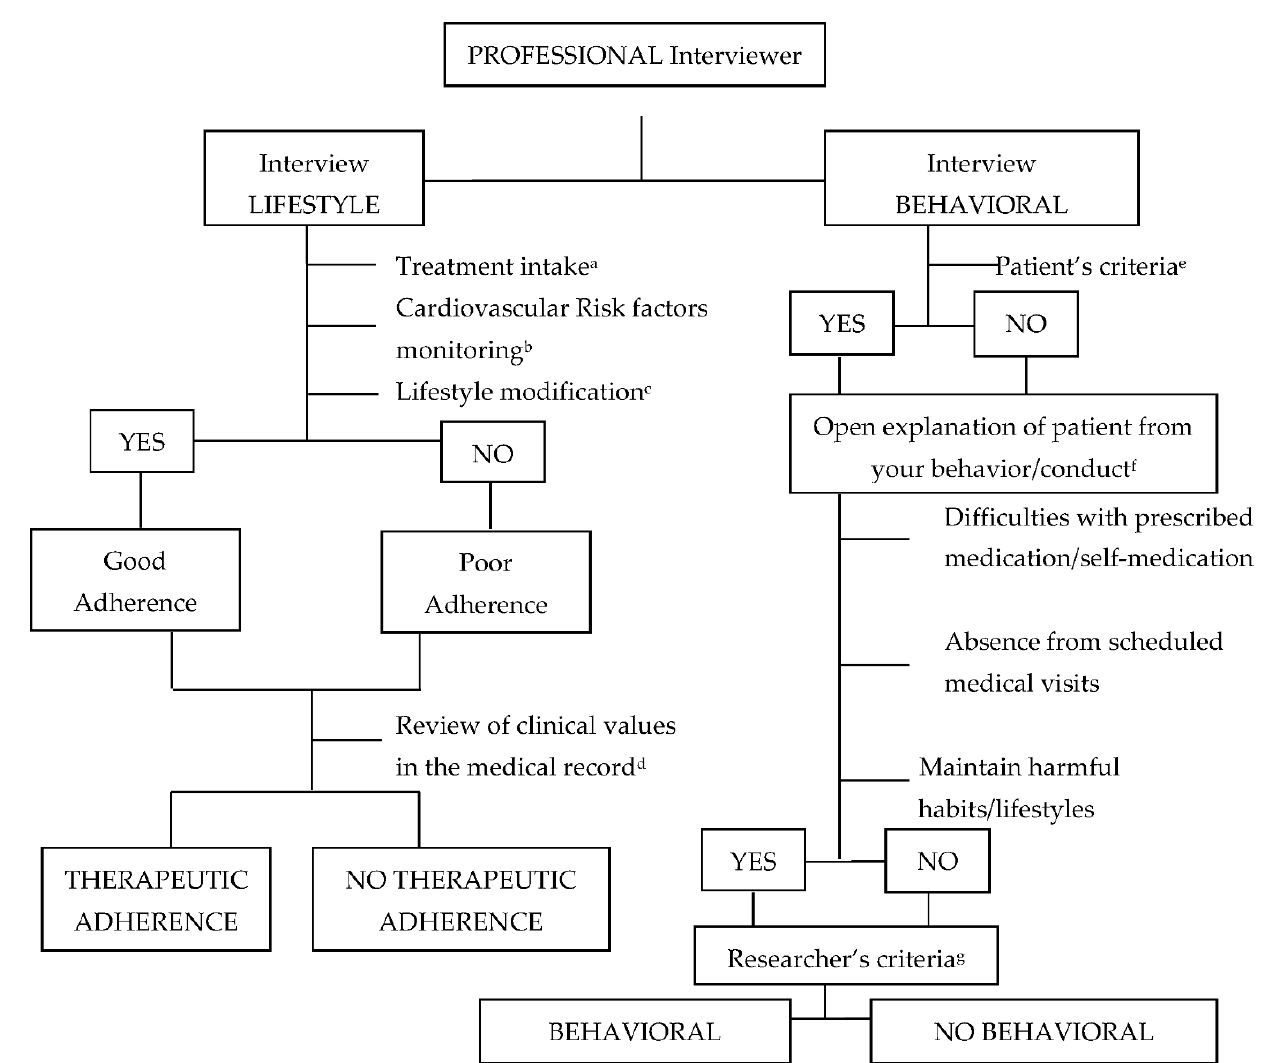
Figure 2. Algorithm to classify lifestyle and behavioral changes. a Patient self-report on taking prescribed medication without missing any doses [19]. b Cardiovascular risk factors present and review of the control measures adopted by the patient [19]. c Changes in lifestyle, such as a healthy diet and aerobic exercise [23]. d Investigator check on the information